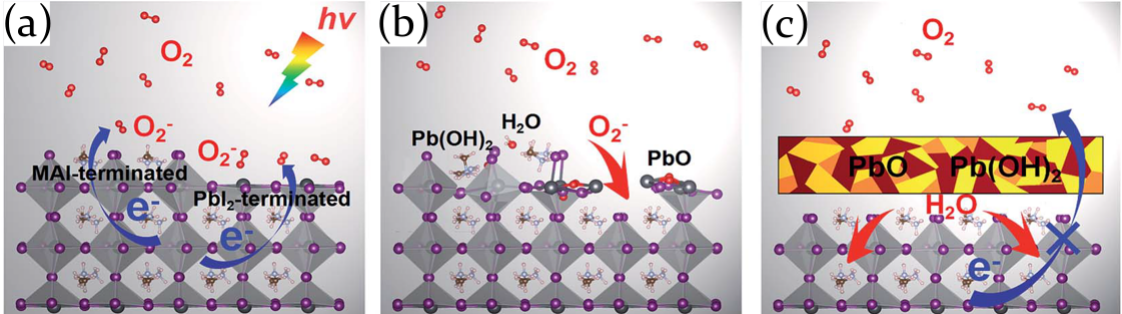
Figure 7. Schematic representation of the photo-oxidative degradation process of the MAPbI 3 surface. ( a ) O 2 molecules close to the surface of MAPbI 3 get the photo-excited electrons from perovskite, forming superoxide anions (O − with MA + and Pb, yielding H 2 O and Pb ( OH ) 2 on the MAI-terminated surface. Oxidation of lead on the PbI 2 -terminated surface leads to the disintegration of the Pb–I bond, producing PbO and leaving the underlying MAI-terminated surface exposed. ( c ) The oxidation products PbO and Pb ( OH ) 2 form a protection layer, preventing the oxidation of inner MAPbI 3 . However, the fresh water molecules produced in previous steps cause hydration of the inner perovskite. Used with permission from the Royal Society of Chemistry from [75], © 2019; permission conveyed through Copyright Clearance Center,